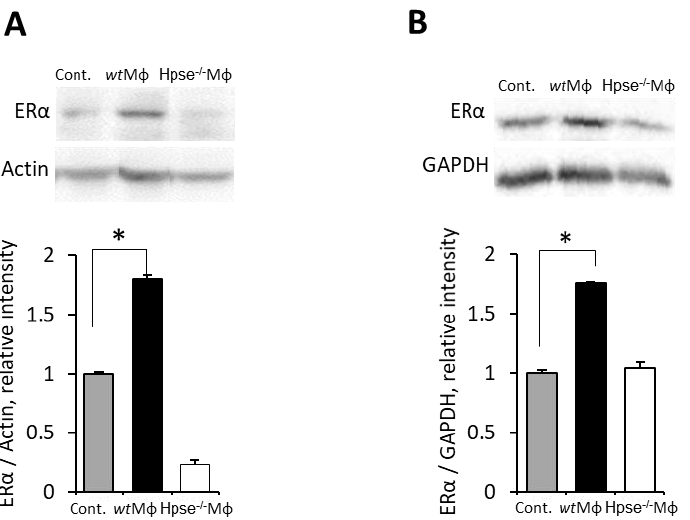
Figure 6. Heparanase- deficient macrophages stimulated by SFA failed to upregulate ERα levels in BC cells. E0771 ( A ) and T47D ( B ) cells either remained untreated (Cont.) or were incubated (24 h, 37 °C) with medium conditioned by macrophages derived from either wild- type (wtMϕ) or heparanase-knockout (Hpse-/- M ϕ ) mice, and stimulated by saturated fatty acid, either palmitic ( A ) or stearic ( B ), as described in Methods. ERα protein levels were determined by immunoblotting (top) and quantified using ImageJ software (bottom). Error bars represent ± SD. * p < 0.002.